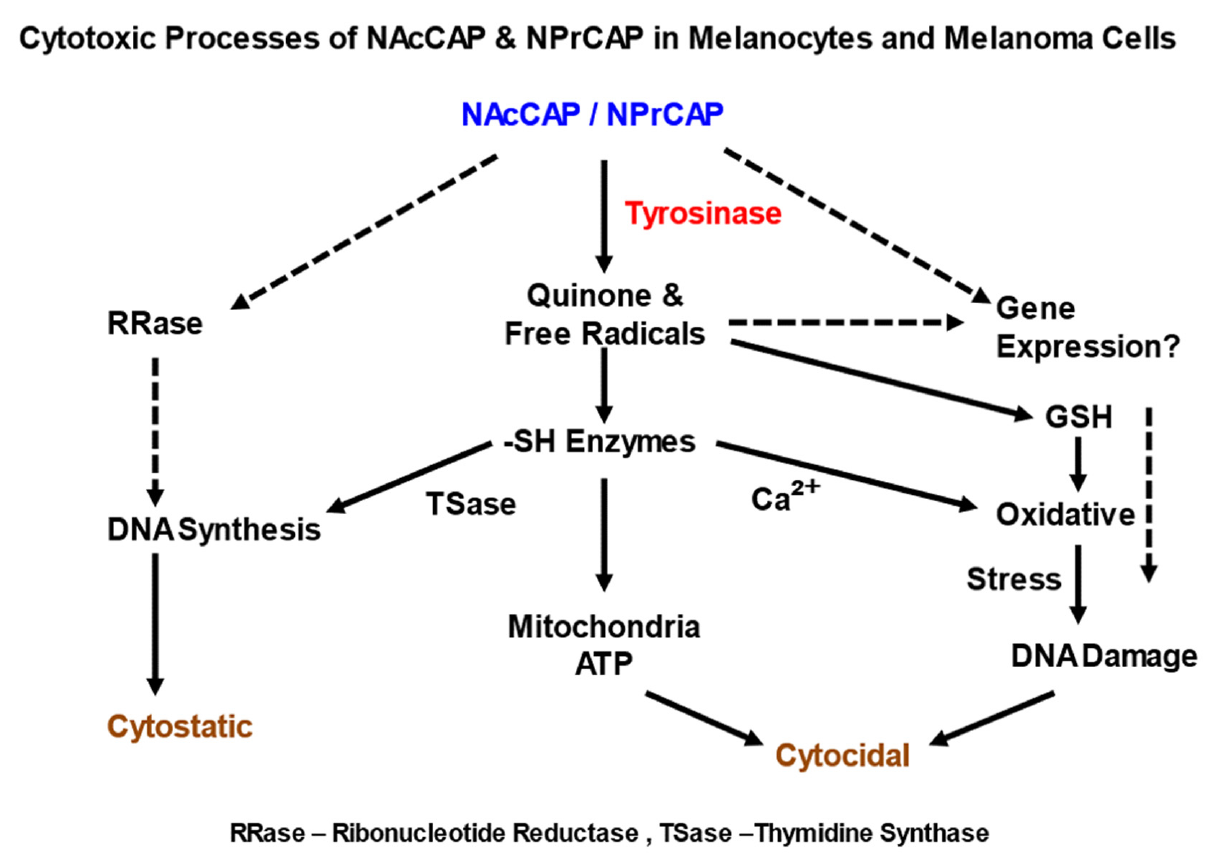
Figure 11. Molecular cascade of cytotoxic action of NAcCAP and NPrCAP in melanocytes and melanoma cells.